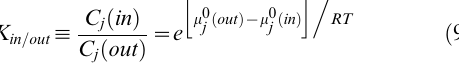
Figure S1 Defining nuclear geometries for simulations. Spatial dimensions used for developing realistic in silico 3D models of yeast nuclei in ( A ) early and ( B ) late anaphase. Figure S2 Diffusion barriers compartmentalize nuclear membranes, but not the nucleoplasm in early and late anaphase. Mean 6 SD fluorescence versus time of nuclei in early (21 cells) and late anaphase (34 cells). FLIP experiments (black) are compared with simulations (red for mother and green for daughter lobe). A hypothetical diffusion barrier permeability P was estimated for TetR-GFP (nucleoplasm), Nsg1-GFP (ONM), Nup49-GFP (NE) and GFP-Src1 (INM). Figure S3 TEM images of yeast nuclei during anaphase. Each row, from top to bottom, shows cells in ( A, B, C ) early anaphase and ( D, E, F ) late anaphase. Zoomed areas from left column are shown in centre and right columns: early anaphase: ( B ) bud neck and ( C ) daughter nuclear lobe; late anaphase: ( E ) whole bridge and ( F ) bridge at neck. The average thickness of perinuclear space ( h p in Fig. 1, measured between the phospholipid heads of inner lipid leaflets facing the periplasm) was 22 6 6 nm at nuclear lobes (regardless of the mitotic stage) and 13 6 4 nm at the connecting bridge (in late anaphase). The staining protocol used was the same as in [65]. Figure S4 Crowding effects occasioned by volume exclusion of the NPC do not affect its compartmental- ization. Nup49-GFP mean 6 SD fluorescence versus time of nuclei in early (21 cells) and late anaphase (34 cells). NPCs were considered as diffusing non-overlapping spheres. Given the number and size of NPCs (Table S1), we estimate a 6.19% and a 6.55% crowding of the NE surface in early and late anaphase, respectively. FLIP experiments (black) are compared with simulations (red for mother and green for daughter lobe). The diffusion barrier permeability was fixed at P= 0.022% for early, and P =0.05% for late anaphase, as estimated previously (Fig.